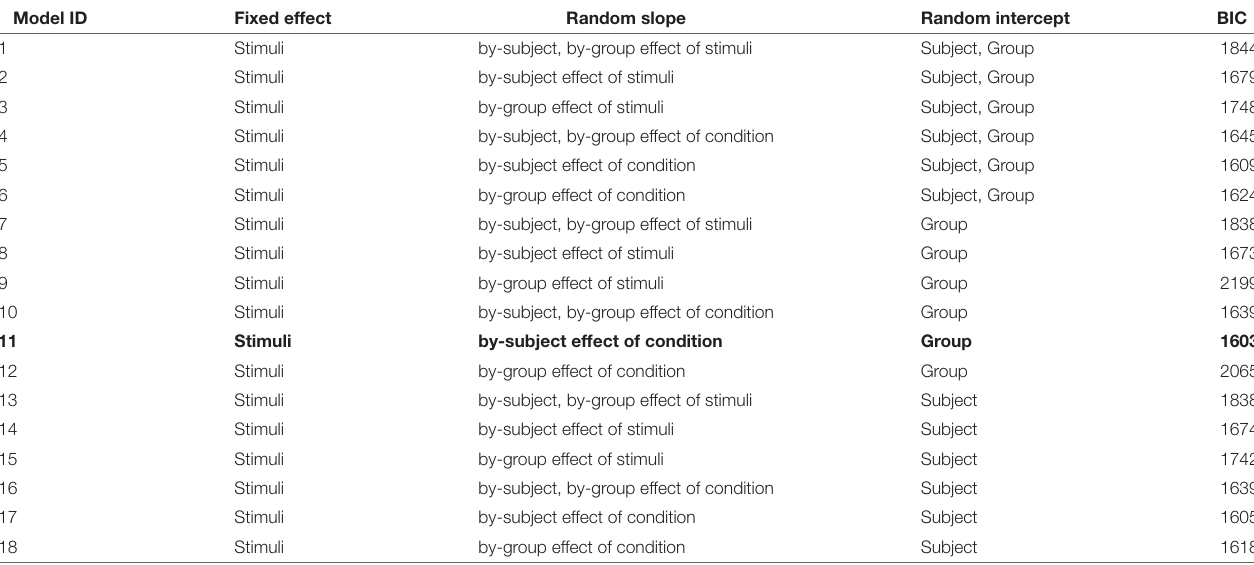
TABLE 1 | Bayesian information criterion (BIC) values for the penalized likelihood model selection. Model ID